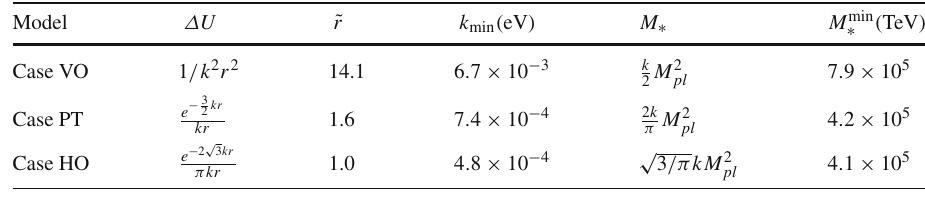
Table 2 Constraints of the scale parameter k and the fundamental M ∗ for the three cases at r = 52 µ